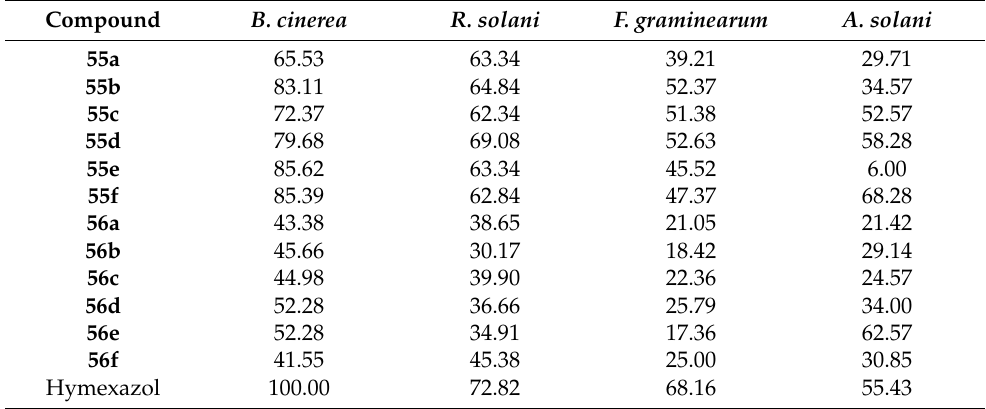
Table 4. Inhibitory rates of the compounds 55 – 56 against four phytopathogenic fungi at 100 ug mL − 1 .